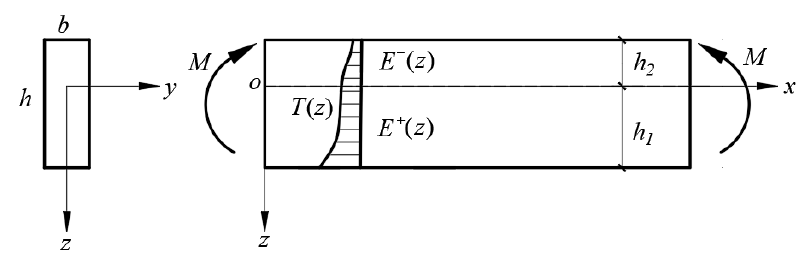
Figure 2. Bimodular FGM beam under bending moment and thermal